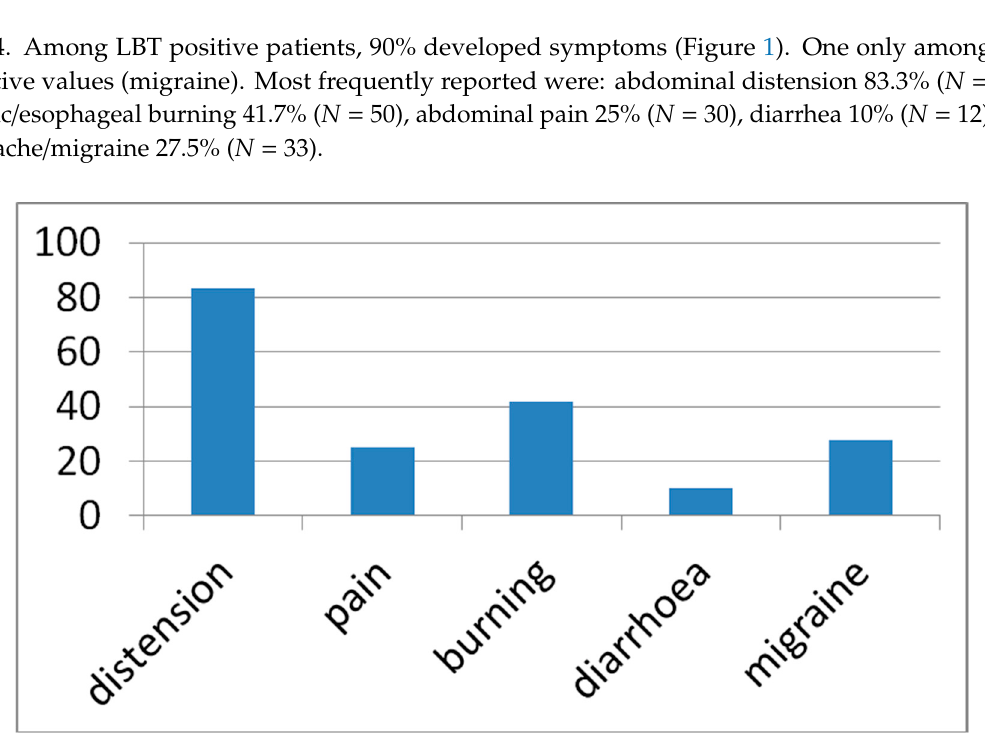
Figure 1. Lactose related symptoms were reported by 90% of LBT positive patients. Data are expressed as the percentage of the total sample. Distension = abdominal distension. Pain = abdominal pain. Burning = hearth (gastro/esophageal) burn.